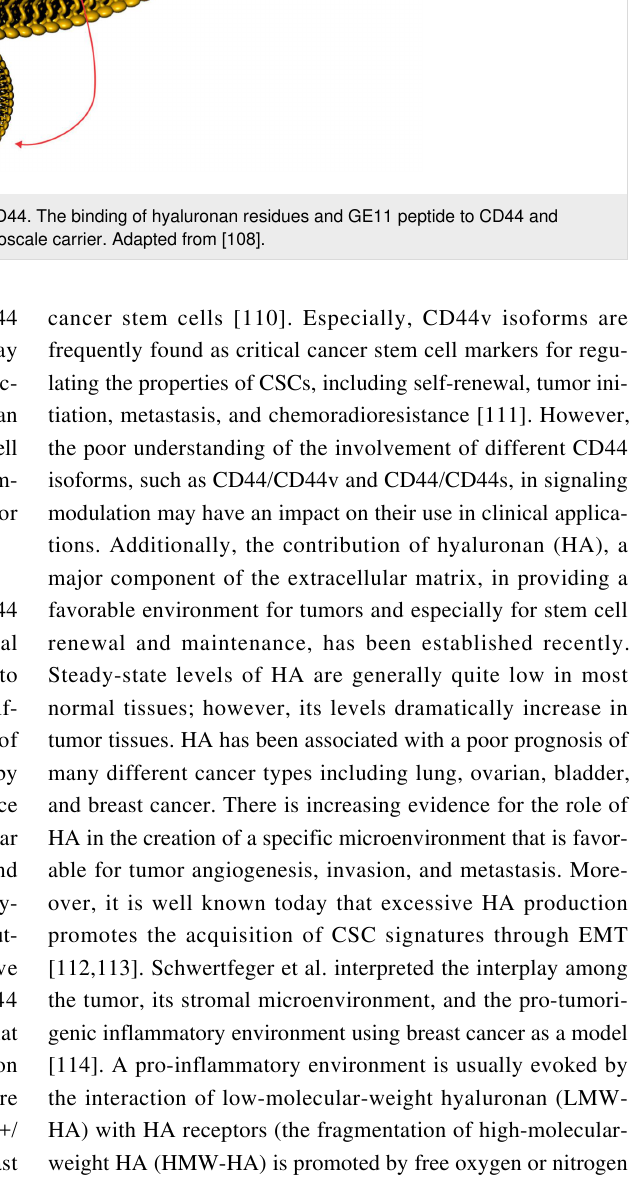
Figure 5: A multifunctional hyaluronan nanogel targeting EGFR and CD44. The binding of hyaluronan residues and GE11 peptide to CD44 and EGFR, respectively, triggers receptor-mediated endocytosis of the nanoscale carrier. Adapted from [108].